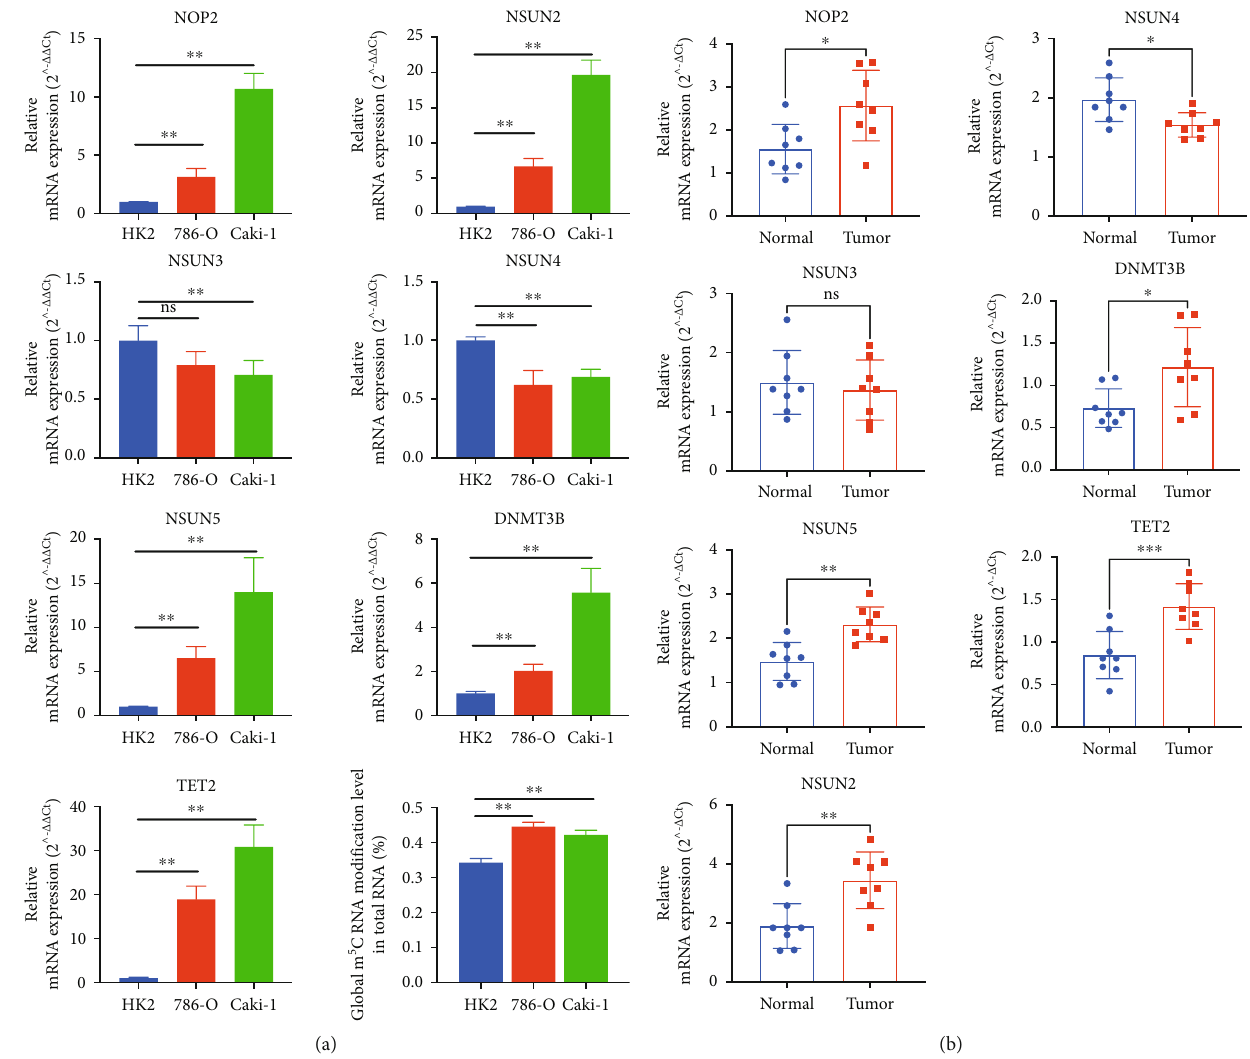
Figure 11: Veri fi cation of seven m 5 C RNA methylation-related genes in vitro and tissue samples. qRT-PCR experiment veri fi ed in renal cancer cell lines (a) and ccRCC tissue samples (b). NOP2, NSUN2, NSUN5, DNMT3B, and TET2 were signi fi cantly upregulated in cell lines and tissue samples, while NSUN4 was downregulated. However, NSUN3 mRNA expression level showed no signi fi cant di ff erence. m 5 C RNA modi fi cation levels in the cell lines were measured by Global RNA Methylation Assay Kit (A). The bar graphs represent means ± standard deviation . ∗∗ p < 0 : 05